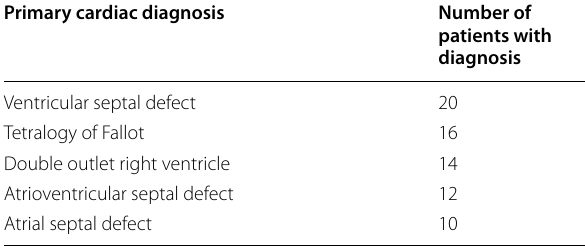
Table 1 Primary cardiac diagnosis for 72